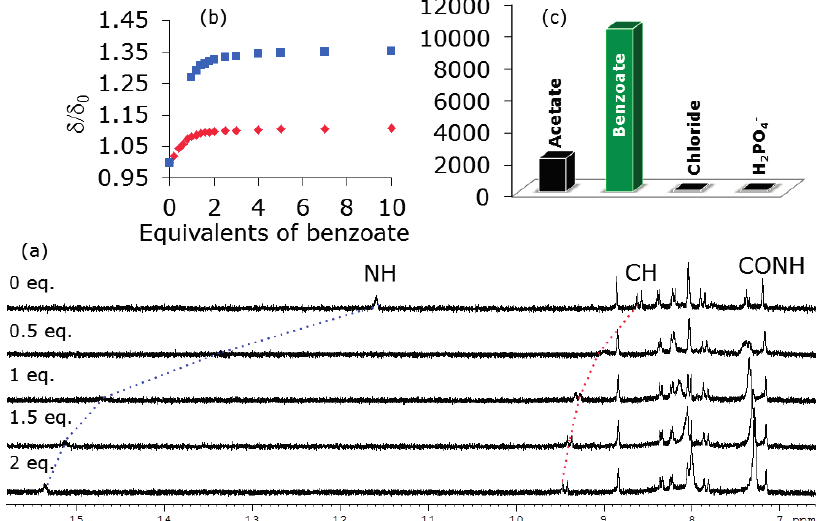
Figure 6. ( a ) Evolution of 1 H-NMR spectra of 3 upon addition of benzoate in DMSO- d ( b ) Titration isotherm for pyrrolic NH (  ) and olefinic CH (  ). [3] = 2 × 10 − 3 M. ( c ) Calculated binding